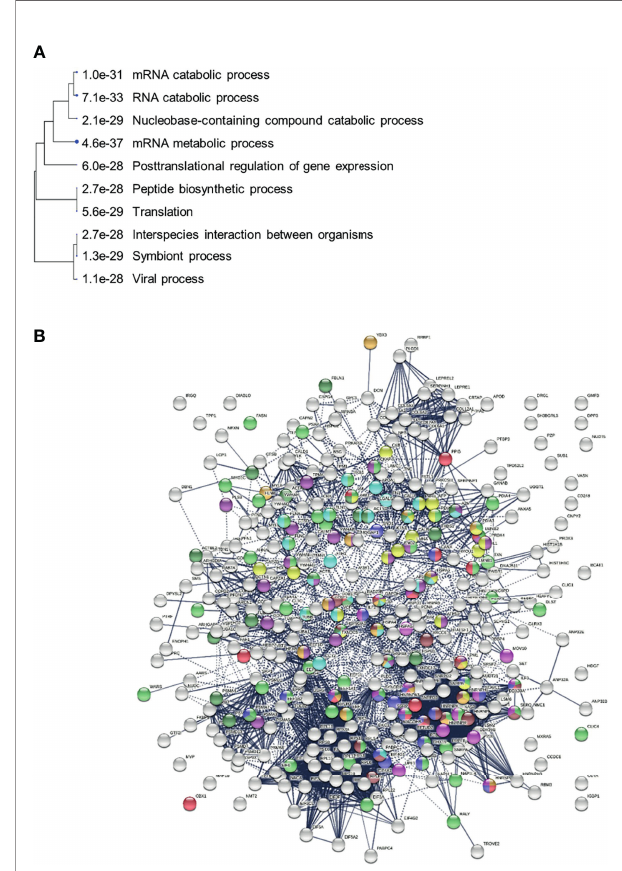
FIGURE 7 | (A) Hierarchical clustering of top 10 pathways involving COVID- altered proteins. Analysis based on hypergeometric distribution followed by FDR correction. (B) COVID-altered host proteins with DS-af fi nity found in various viral infections. Porcine reproductive and respiratory syndrome (56 proteins, green), H5N1 avian in fl uenza virus (27 proteins, dark purple), Japanese encephalitis virus (23 proteins, gold), Rift Valley fever virus (24 proteins, aqua), Hepatitis B virus (22 proteins, dark green), HIV (identi fi ed in different studies, 18 amber, 18 brown, 18 red and 17 pink), and shared among positive-sense RNA viruses (20 proteins,